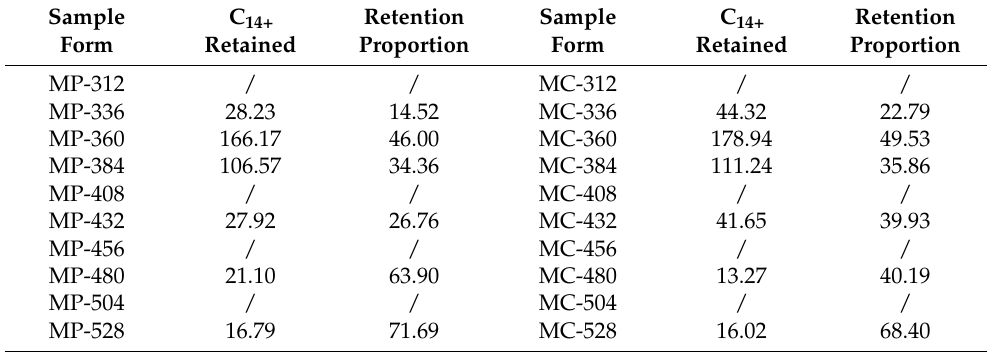
Table 3. Yields of hydrocarbon retention and proportion for core plugs and powdered